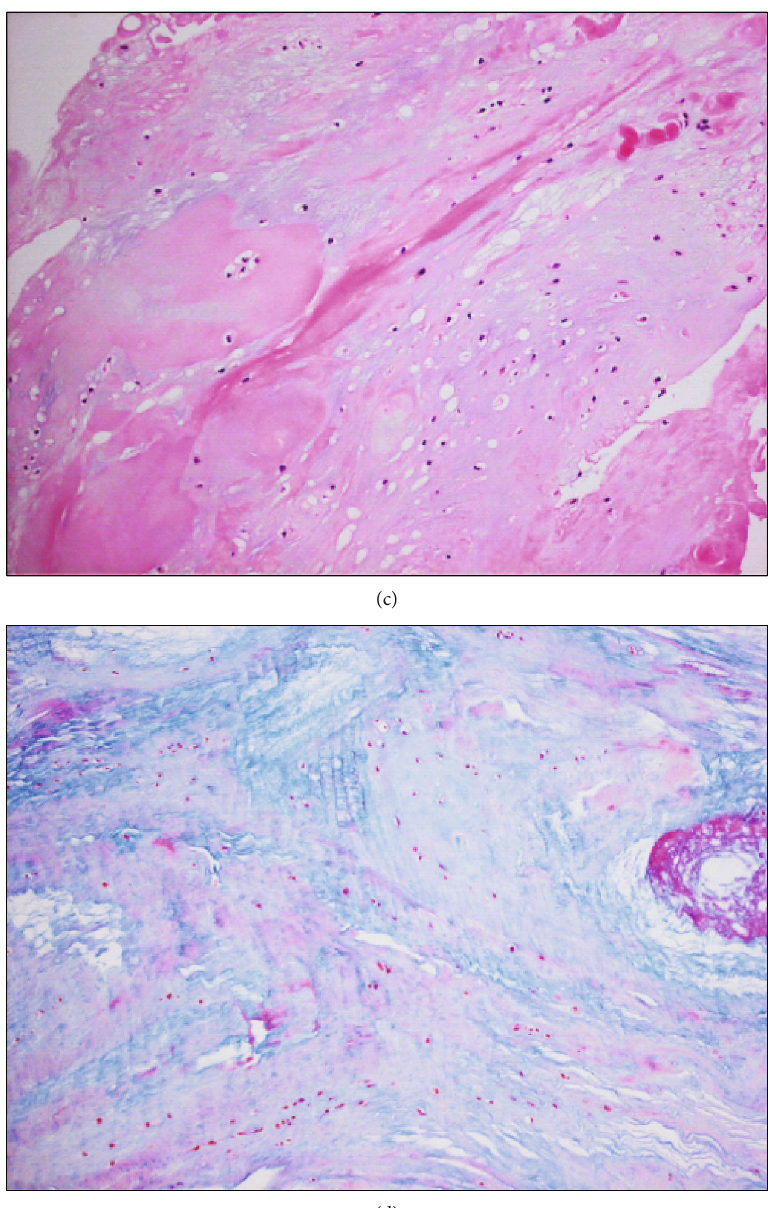
Figure 5: (a, c) Both hematoxylin and eosin stain, (b) Alcian blue stain, and (d) Masson trichrome stain. All of these results indicated the presence of mucoid